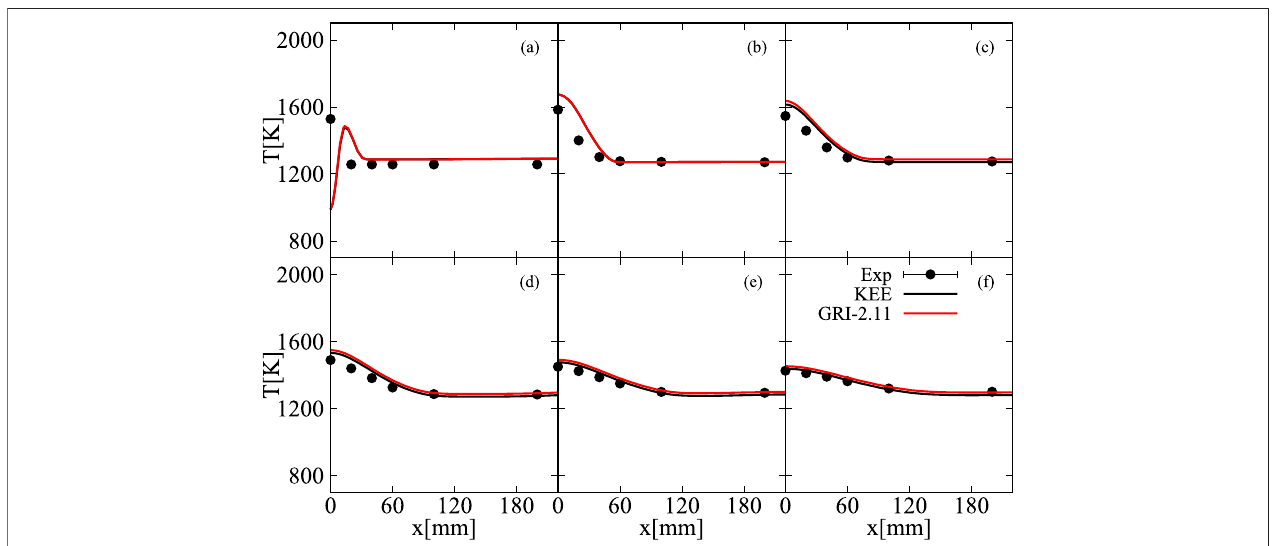
FIGURE 3 | Comparison between experimental, GRI2.11 and KEE results for case 2 at several axial locations: z (cid:1) (A) 100 mm (B) 200 mm (C) 300 mm (D) 400 mm (E) 500 mm (F) 600 mm.